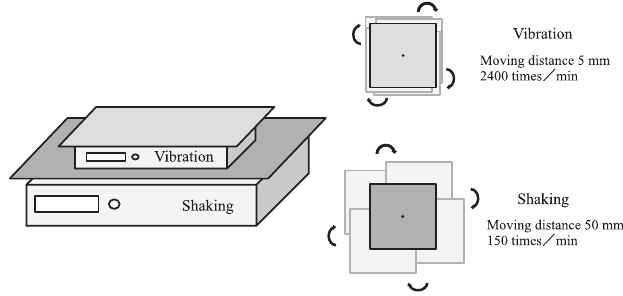
Figure 2 Stimulation equipment A horizontal rotation device that can administer uniform 360° horizontal shaking stimulations at 150 times/min (NX-25D; Nissin Scientific Corporation, Tokyo, Japan) is shown. The other device is a vibrator that can administer 5-mm tornado-type vibrations at 2400 times/min (SK-40- D1; Nissin Scientific Corporation). These stimulation devices were combined into a “vibration and